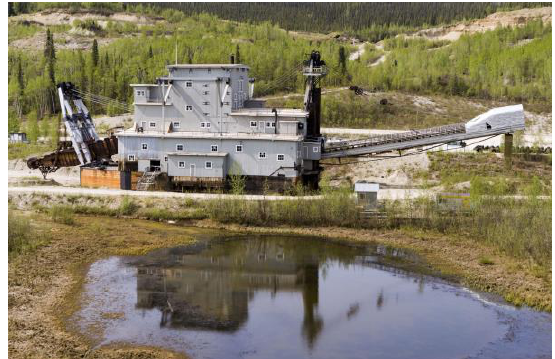
Figure 6: Dredge No. 4 National Historic Site of Canada.